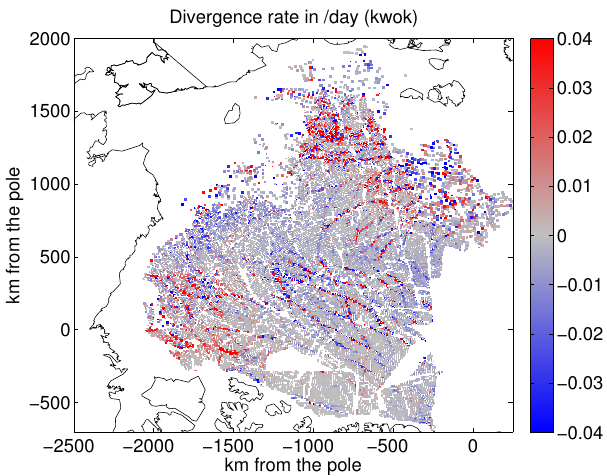
Figure 8. Composite picture of the unfiltered divergence rate com- puted after the first step of our method for the period 2–10 February 2007.